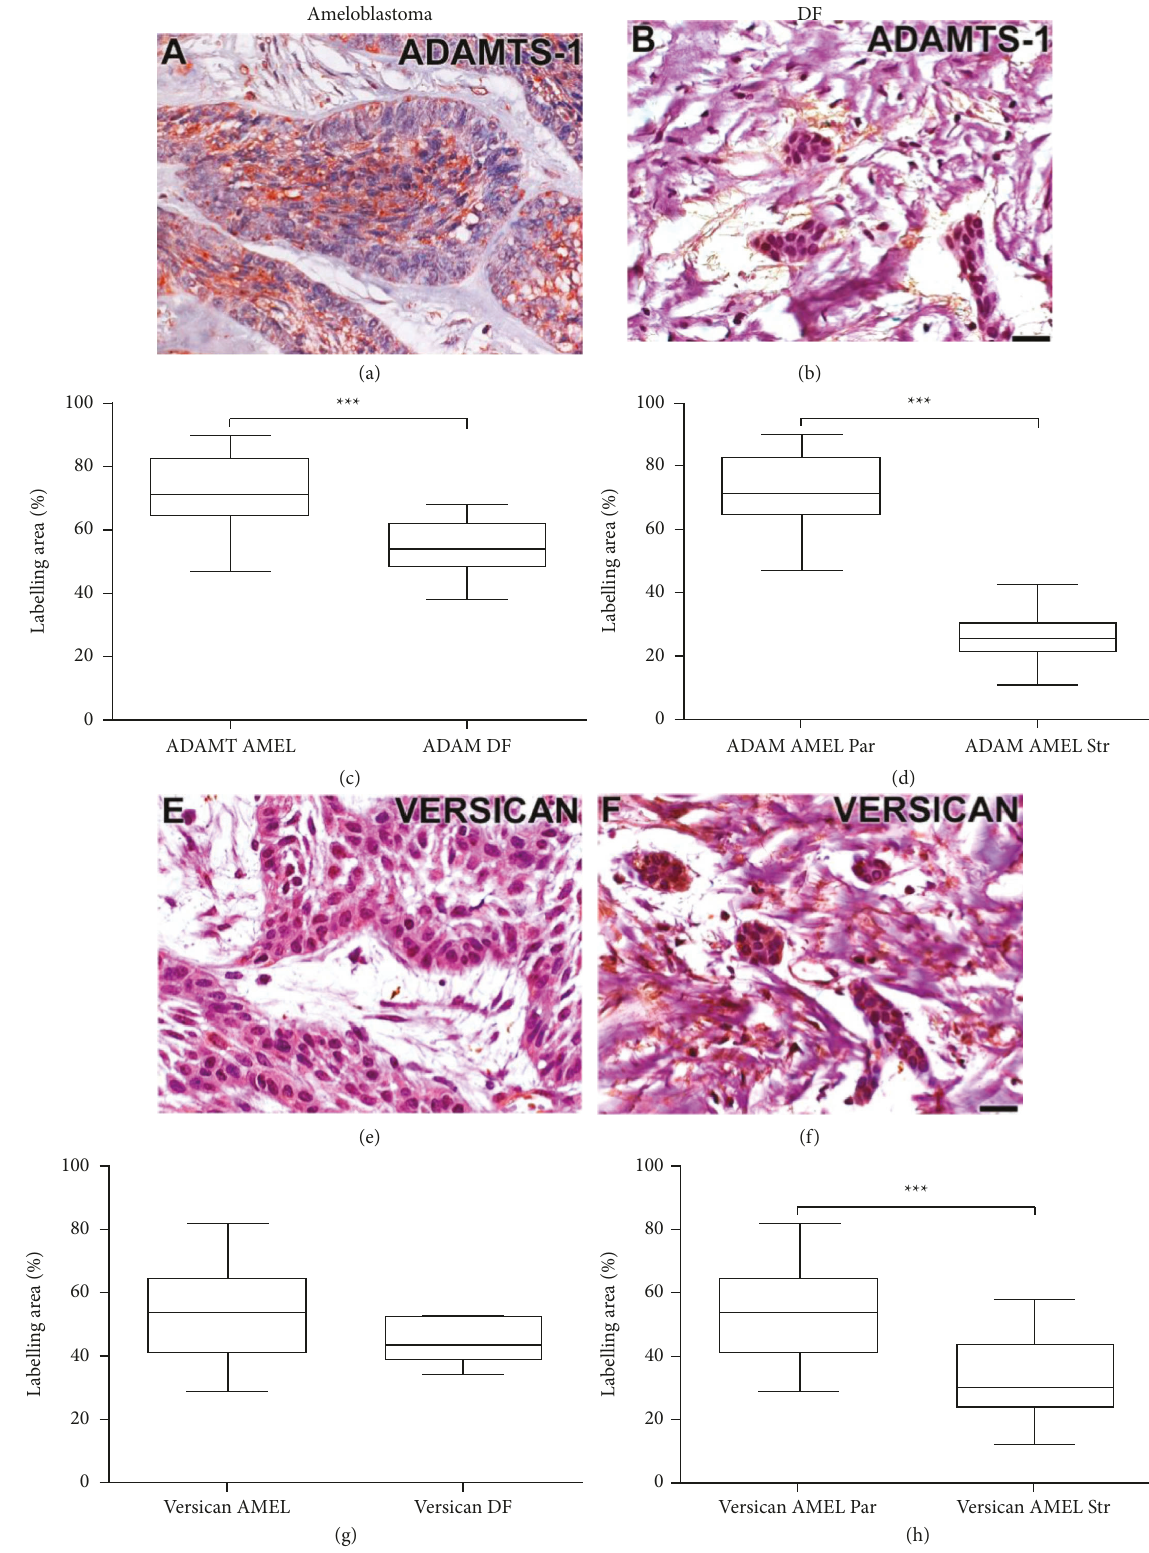
Figure 2: ADAMTS-1 and versican immunostaining in ameloblastoma (AMEL) and dental follicle (DF). ADAMTS-1 has stronger staining in ameloblastoma and is present in cells cytoplasm and nucleus (a) The DF also expressed ADAMTS-1, but limited to small areas. (b) ADAMTS-1 labeling area shows neoplastic cells of ameloblastoma with higher expression than epithelial cells of DF. (c) The immu- nostaining of ADAMTS-1 in ameloblastoma is most prominent in parenchyma (Par) than stroma (Str). (d) Versican immunoexpression in neoplastic cells of ameloblastoma in the epithelium and the stroma. (e) Dental follicle expressed versican. (f) There was no difference in labeling area of versican in ameloblastoma and DF. (g) The immunostaining of versican in ameloblastoma is most prominent in parenchyma than stroma. (h) Significance: ∗∗∗ p < 0 . 001. Scale bar: 20 μ